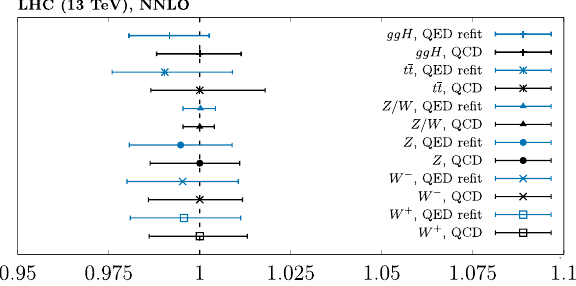
Fig. 7 Benchmark cross sections obtained with NNLO fits to the MSHT20 dataset, with QED effects included to that without. Results are normalized to the central value of the QCD only